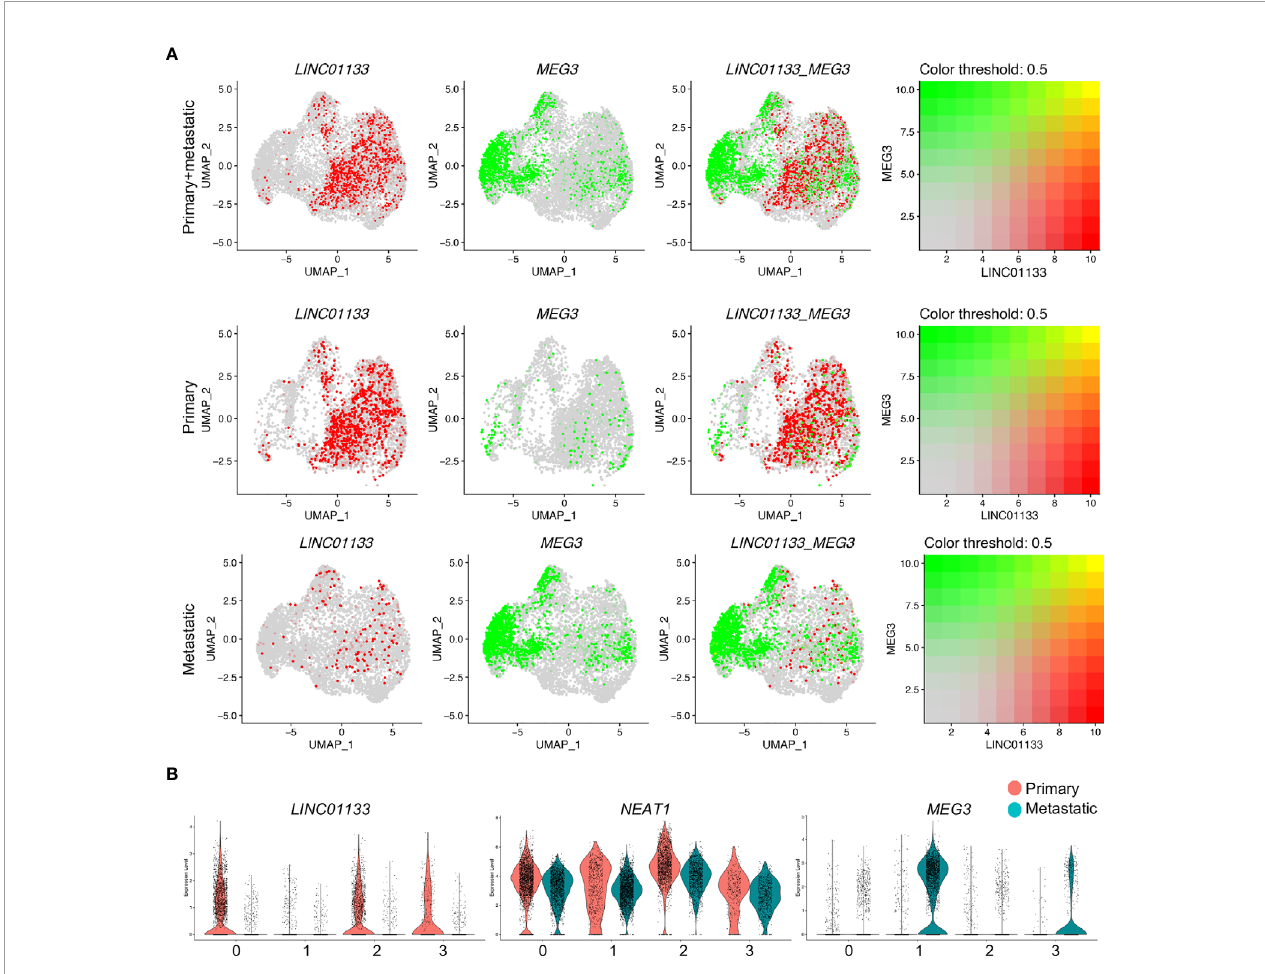
FIGURE 4 | LINC01133 and MEG3 marked primary and metastatic PDAC cancer cell clusters, respectively. (A) Relative expression and colocalization of LINC01133 and MEG3 in integrated cancer cells, primary and metastatic cancer cells by blended UMAPs. (B) Comparison of LINC01133 and MEG3 expression in each cluster between primary and metastatic cancer cells by split violin plots. Notably, MEG3 + cancer cells were mostly distributed in Cluster 1 and derived from metastatic PDAC cancer, while LINC01133 + cancer cells were mostly distributed in Clusters 2 and 3 and derived from primary PDAC